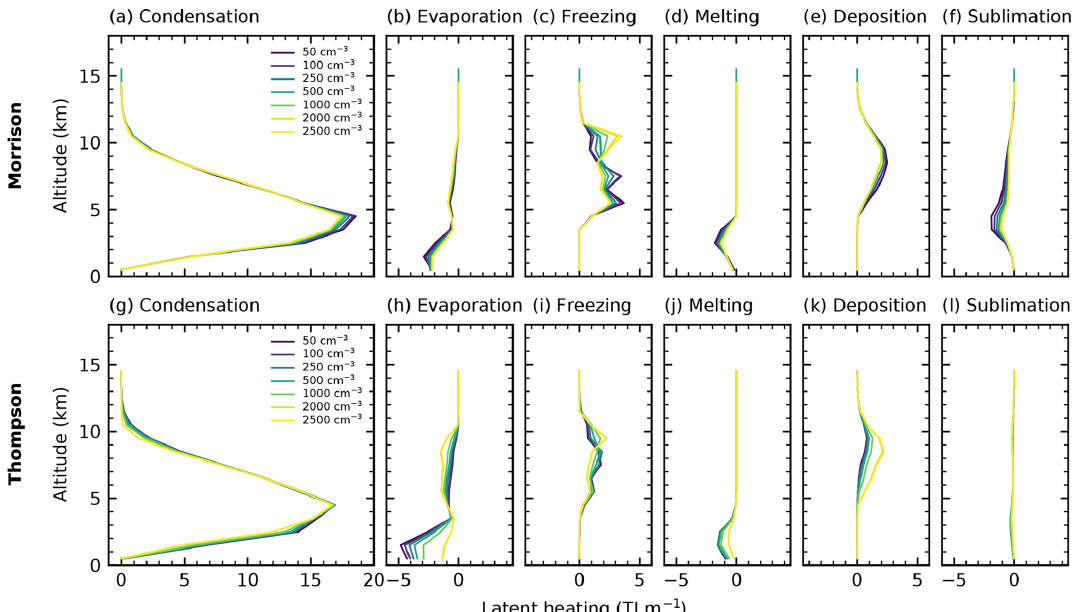
Figure 11. Profiles of the components of the latent heating and cooling over the lifetime of the tracked cell for the two bulk microphysics schemes in